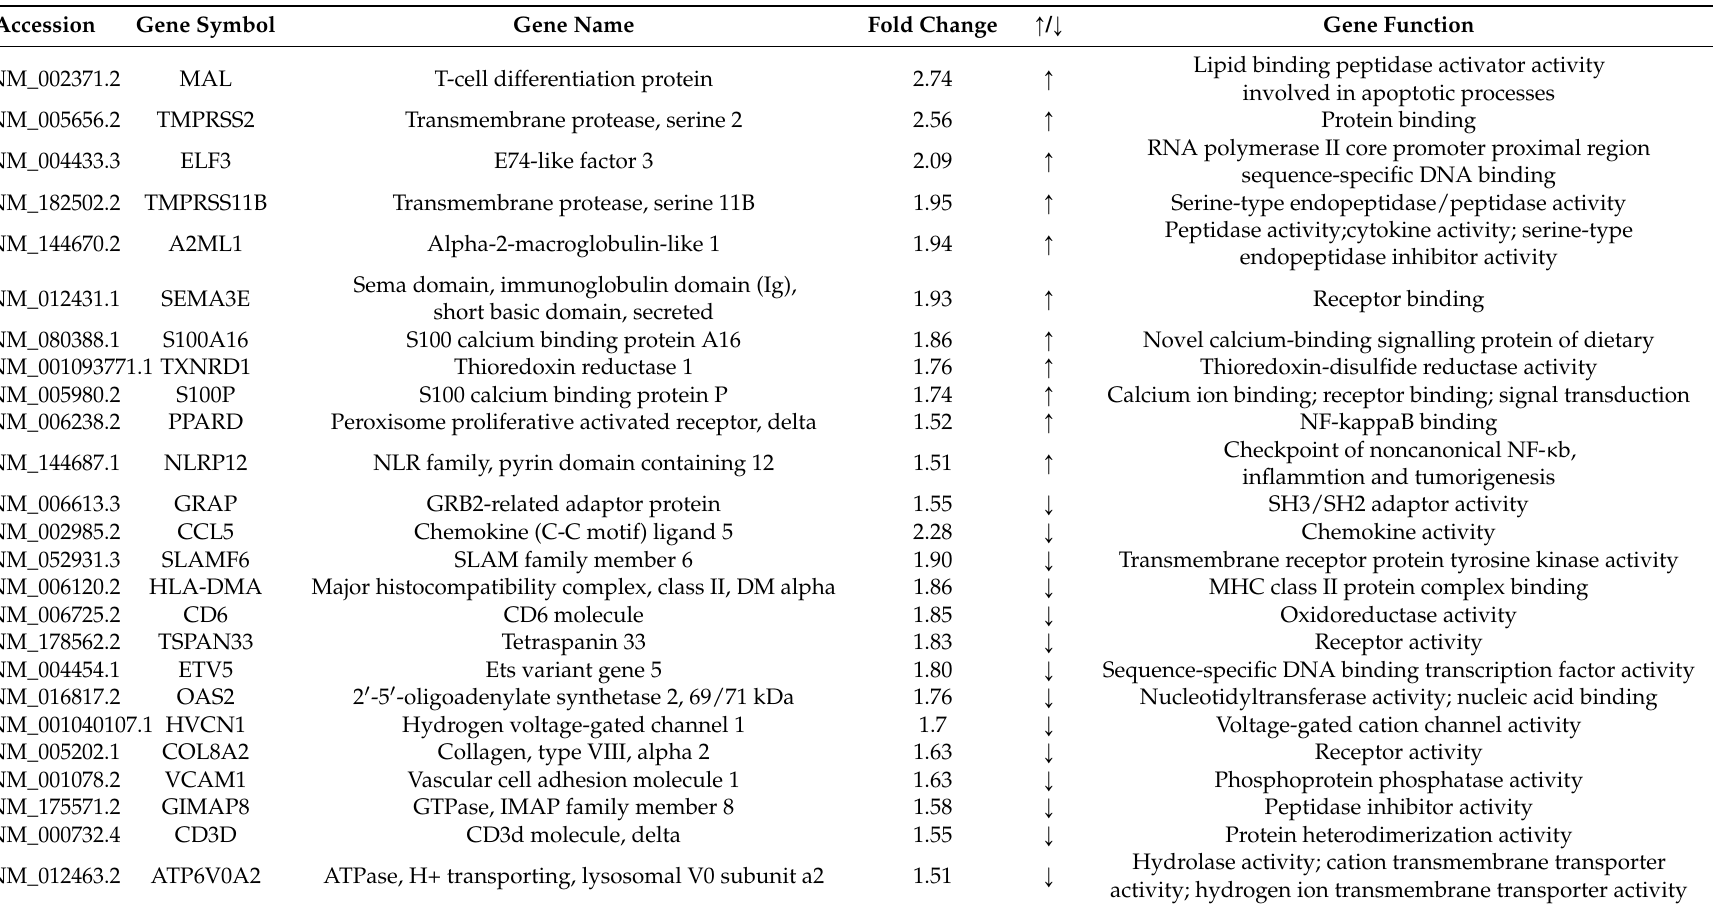
Table 3. 25 Genes involved in the immune system process with their gene functions, fold change and direction of change in regulation in sputum from asthmatics at 4 h after a high fat meal compared with